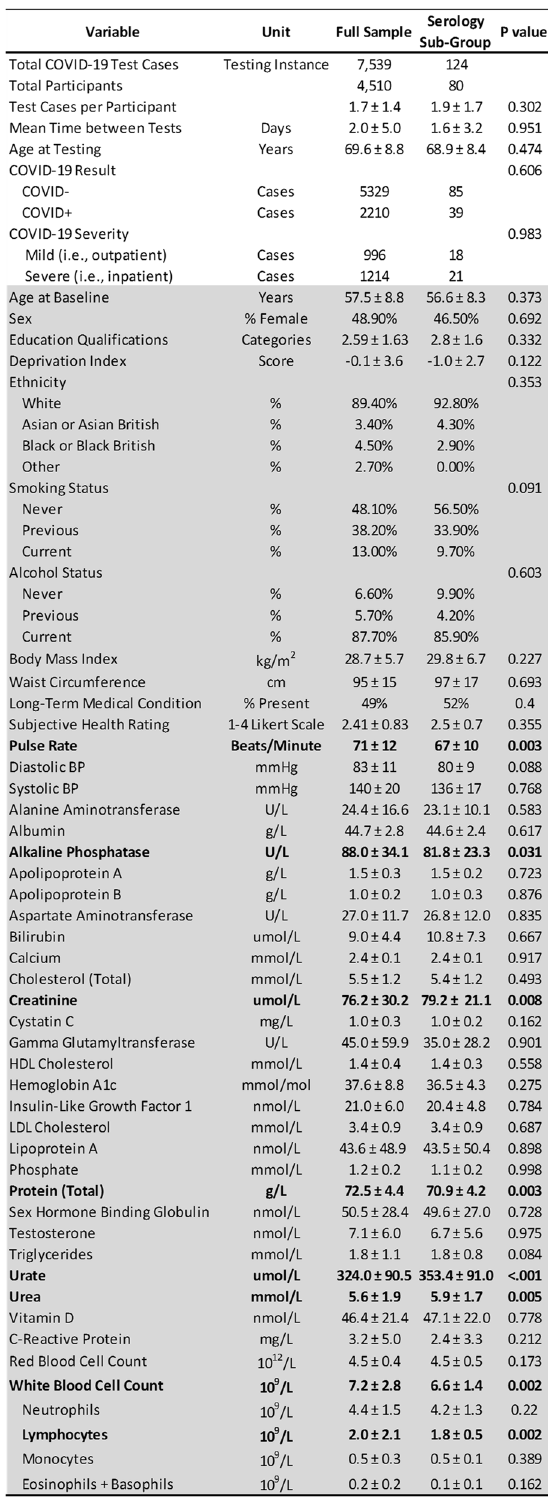
Table 1. Baseline Demographics and Data Characteristics. Blood pressure (BP); high-density lipoprotein (HDL); low-density lipoprotein (LDL). A summary and comparison of data among either all participant